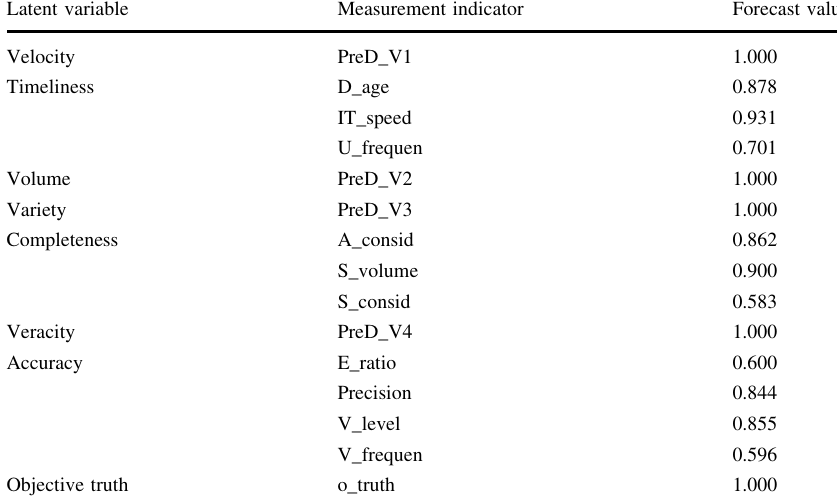
Table 5 Results from the forecast validity of the measurement